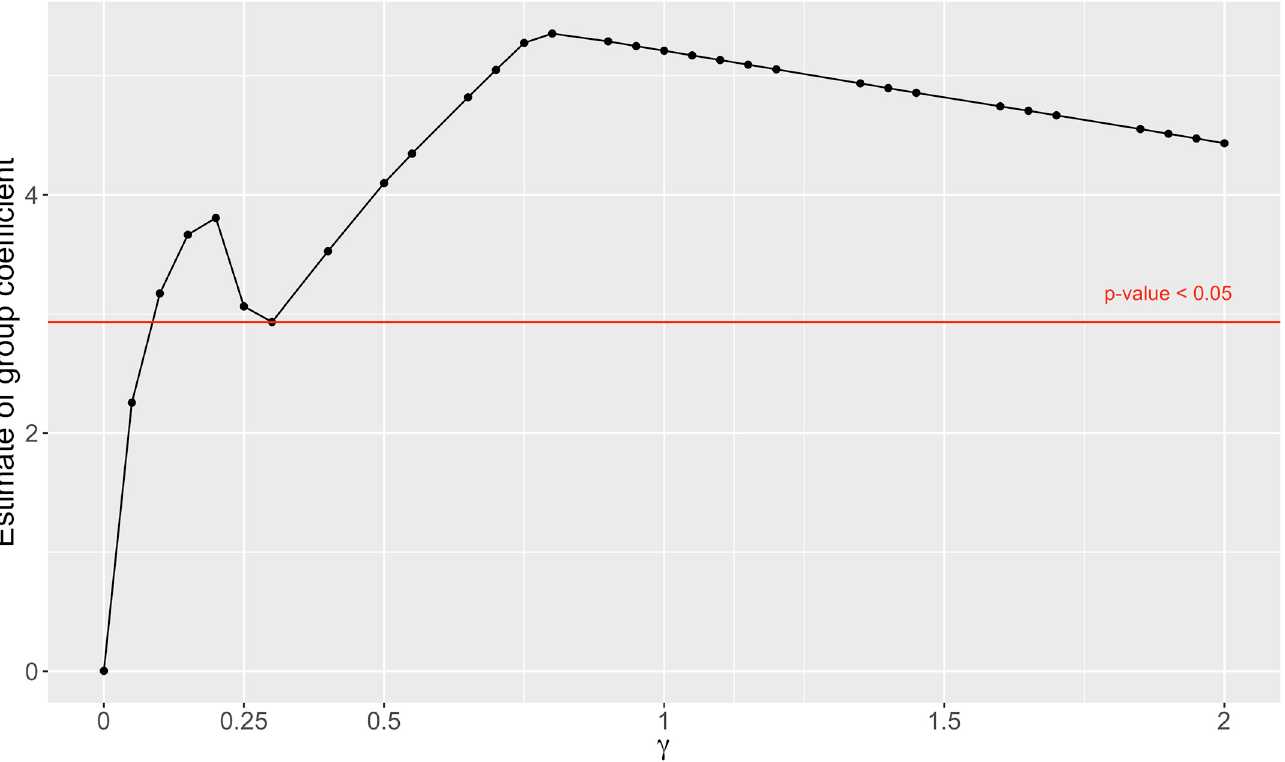
Fig 2. Estimated group coefficient β 1 vs. γ for THC . The group coefficient β 1 is estimated at different γ values. Any coefficients above the red line are statistically significant with p < 0.05, the red line crosses the curve at the point ð g ¼ 0 : 3 ; ^ b